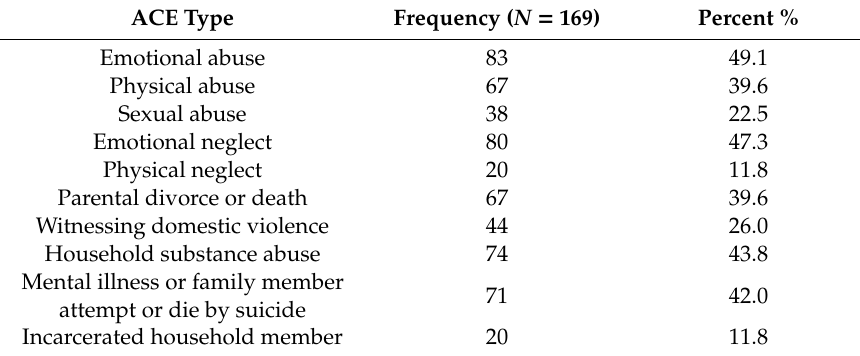
Table 3. Frequency and percentage of ACEs by